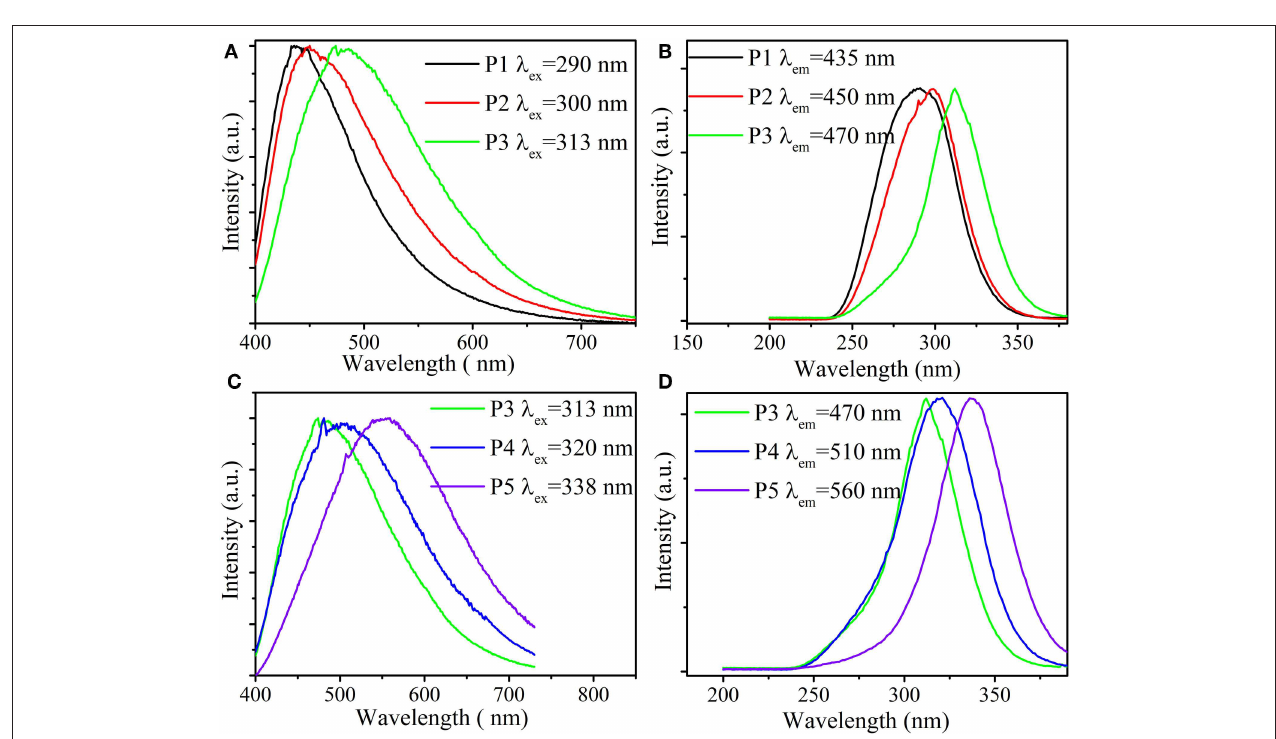
FIGURE 2 | Emission (A) and excitation (B) spectra of samples P1–P3 as increasing optical basicity of glass. Emission (C) and excitation (D) spectra of samples P3–P5 with growing Cu + content.